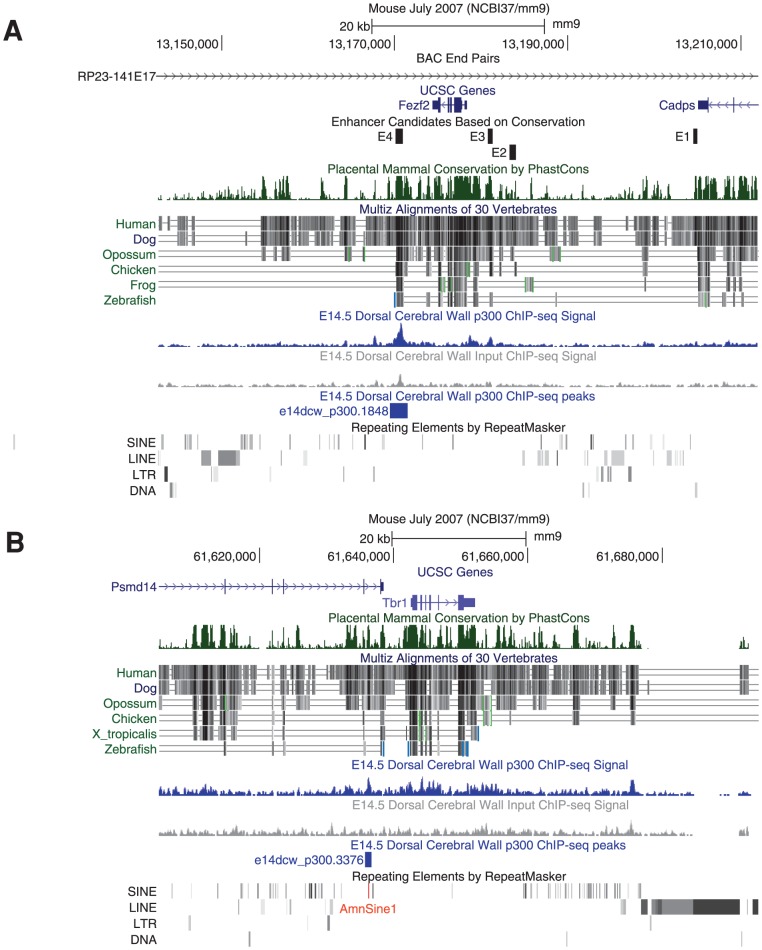
p300 peaks next to key neocortical developmental genes.A) A single E14.5 p300 peak (blue) is found in 180 kb of the RP23-141E17 BAC investigated in [8]. This peak contains the E4 developmental enhancer whose genomic deletion leads to aberrant cortico-spinal projection fates, similar to those found in its Fezf2 target gene conditional knock-out. As suggested by our data, only deletion of E4, but not E1, E2 or E3 from the BAC resulted in reduced neocortical expression from the Fezf2 locus. B) Tbr1 and Fezf2 act antagonistically to determine cortical neuron projection fates. A single E14.5 p300 peak is found proximal to the Tbr1 gene. This pan-mammalian conserved peak has likely been seeded by the co-option of an AmnSine1 instance (red) at its center.